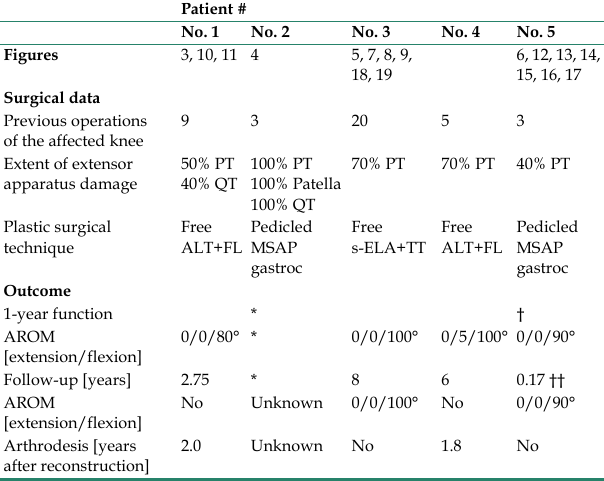
Table 1: Orthoplastic treatment and outcome.